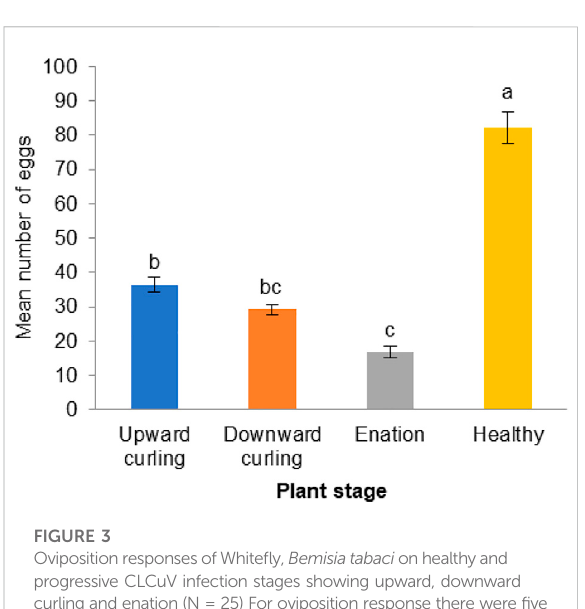
FIGURE 3 OvipositionresponsesofWhite fl y, Bemisiatabaci onhealthyand progressive CLCuV infection stages showing upward, downward curling and enation (N = 25) For oviposition response there were fi ve replications each replication consist of one clip cage with fi ve pairs of white fl ies. Bars denoted by common letter indicate a non- signi fi cant difference in the mean number of eggs (Tukey ’ s